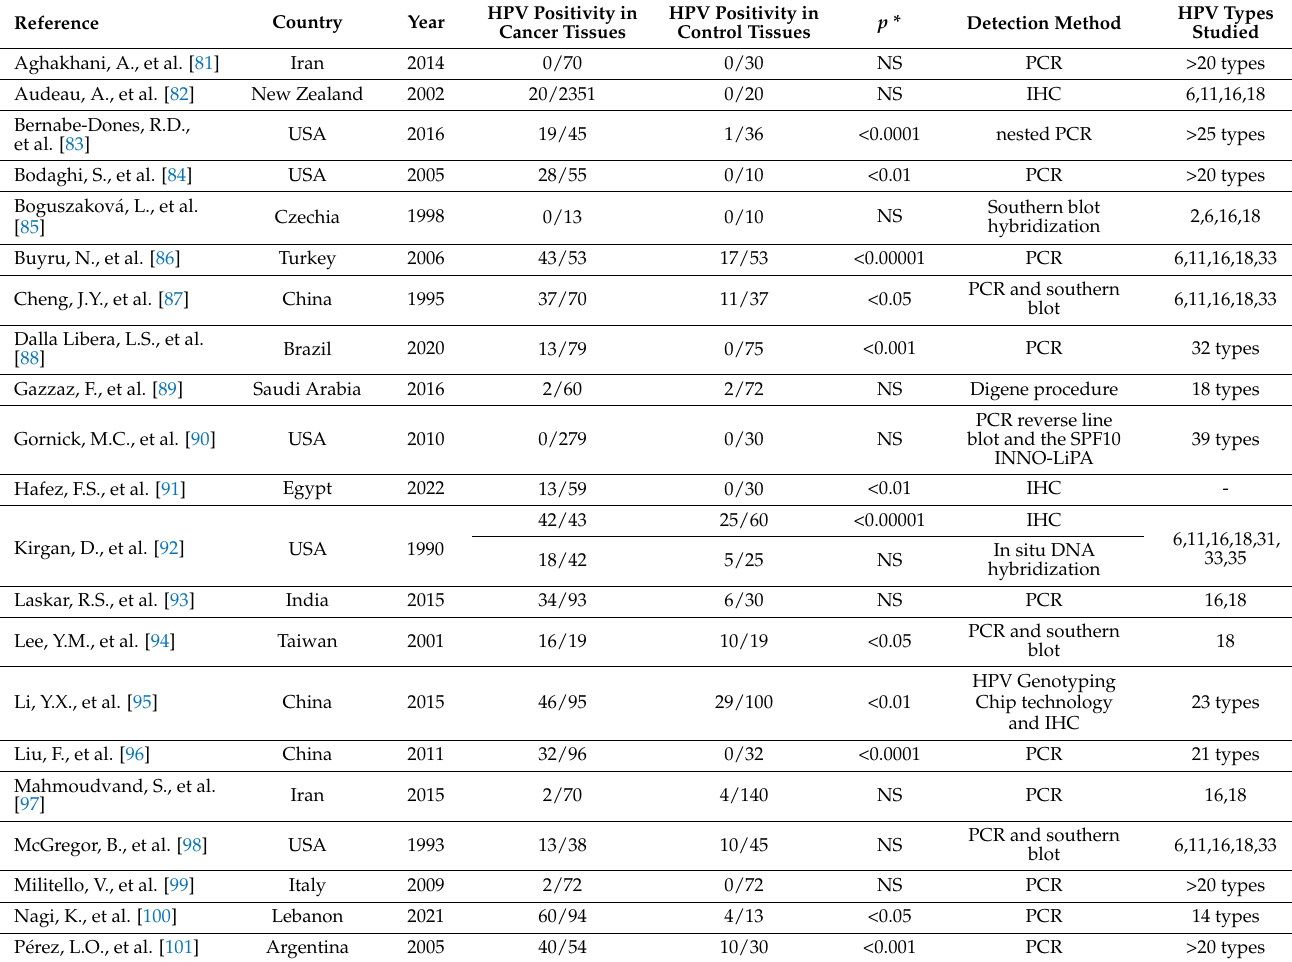
Table 4. Summary of the studies on the human papillomavirus in colorectal